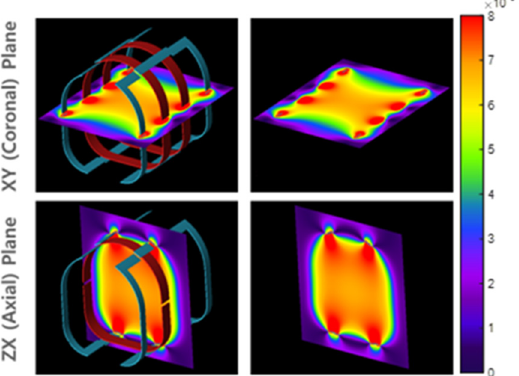
Figure 2. Circularly polarized (CP) excitation magnetic field (B 1 in Tesla) of the head RF coil model under the unloaded condition.